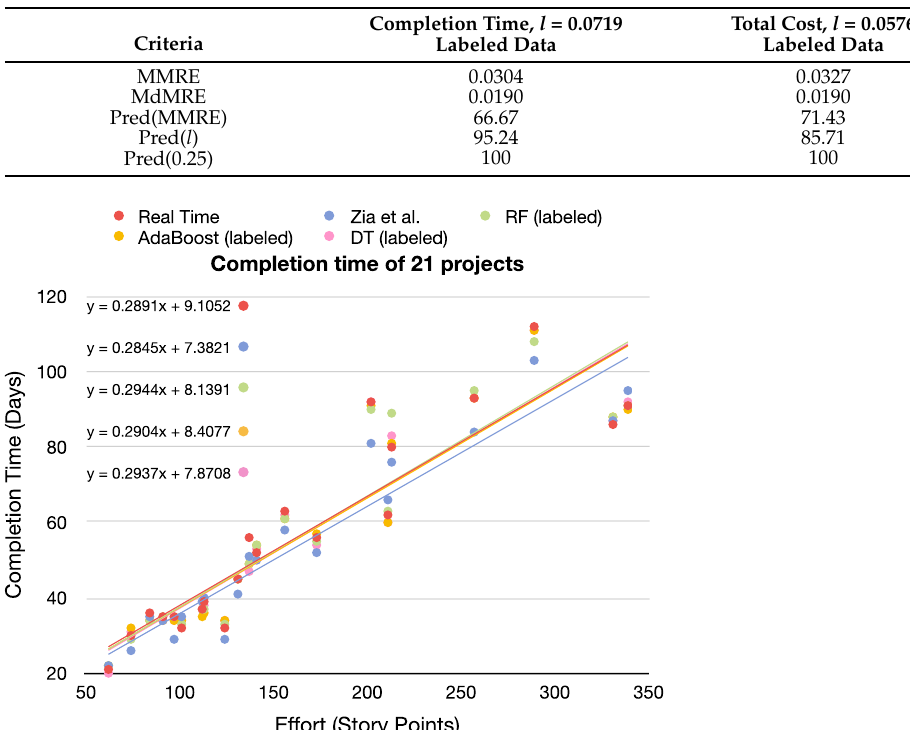
Table 13. Comparison of final ensemble evaluation metrics.